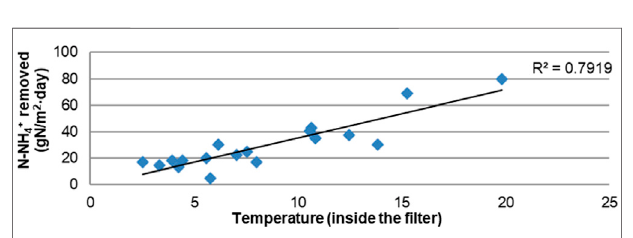
FIGURE 6 | Correlation of N-NH 4+ removal with temperature inside the fi lter and effect of temperature on TKN removal in the VFCW (Filter 1, HL (cid:2) 5.6 cm/day, one